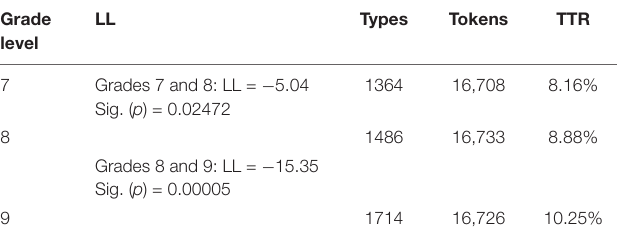
TABLE 3 | Type-token ratio (TTR) per grade level. TABLE 4 | Number of word types 4 per word list and per grade level.